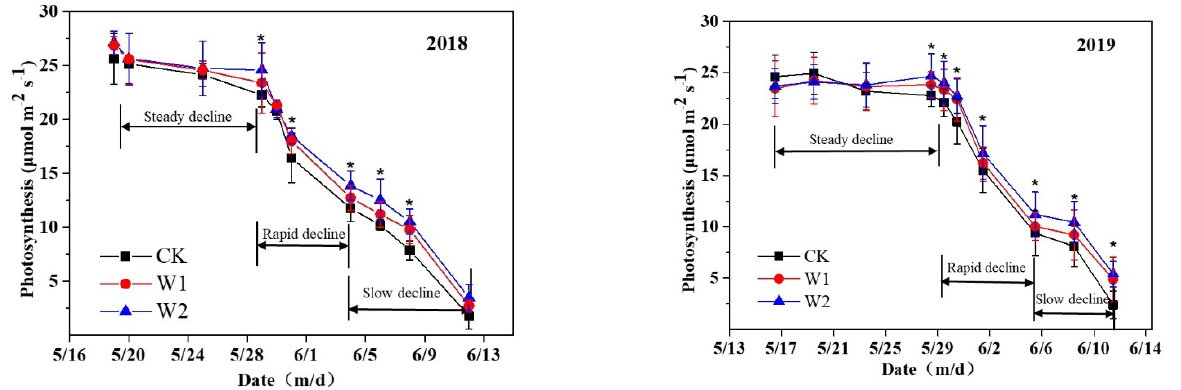
Figure 6. The photosynthetic rate during the grain filling stage under different treatments in 2018 and 2019. The values are the mean ± standard error ( n = 3). * = significant at a probability level of p < 0.05 according to the Least Significant Difference test. W1, W2, and CK represent 2.5 mm, 5 mm, and no irrigation treatments during dry-hot wind condition, respectively.